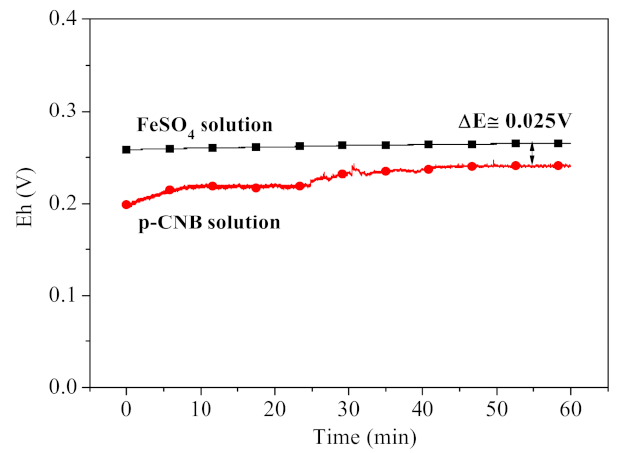
Figure 7. The redox potential of FeSO 4 solution and p-CNB solution (concentration of p-CNB = 10 mg/L, concentration of FeSO 4 = 10 mmol/L and initial pH = 5.6 ±